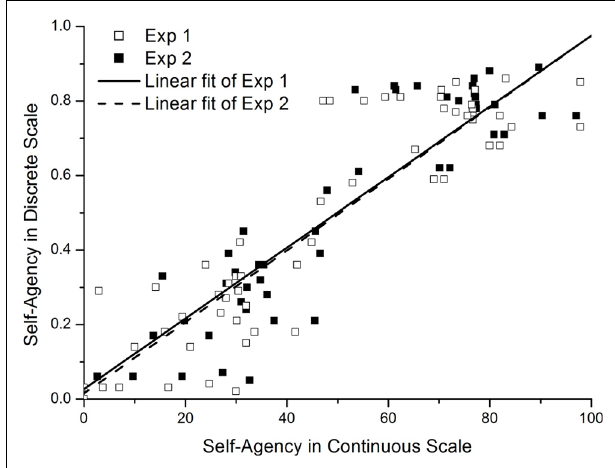
FIGURE 3 | Correlation between the self-agency ratings obtained from continuous and discrete scale.